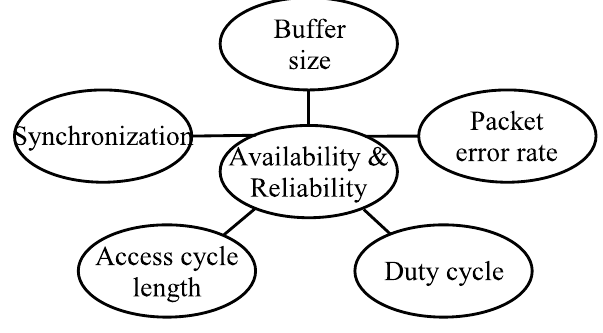
Figure 1. Factors affecting availability and reliability evaluated in this